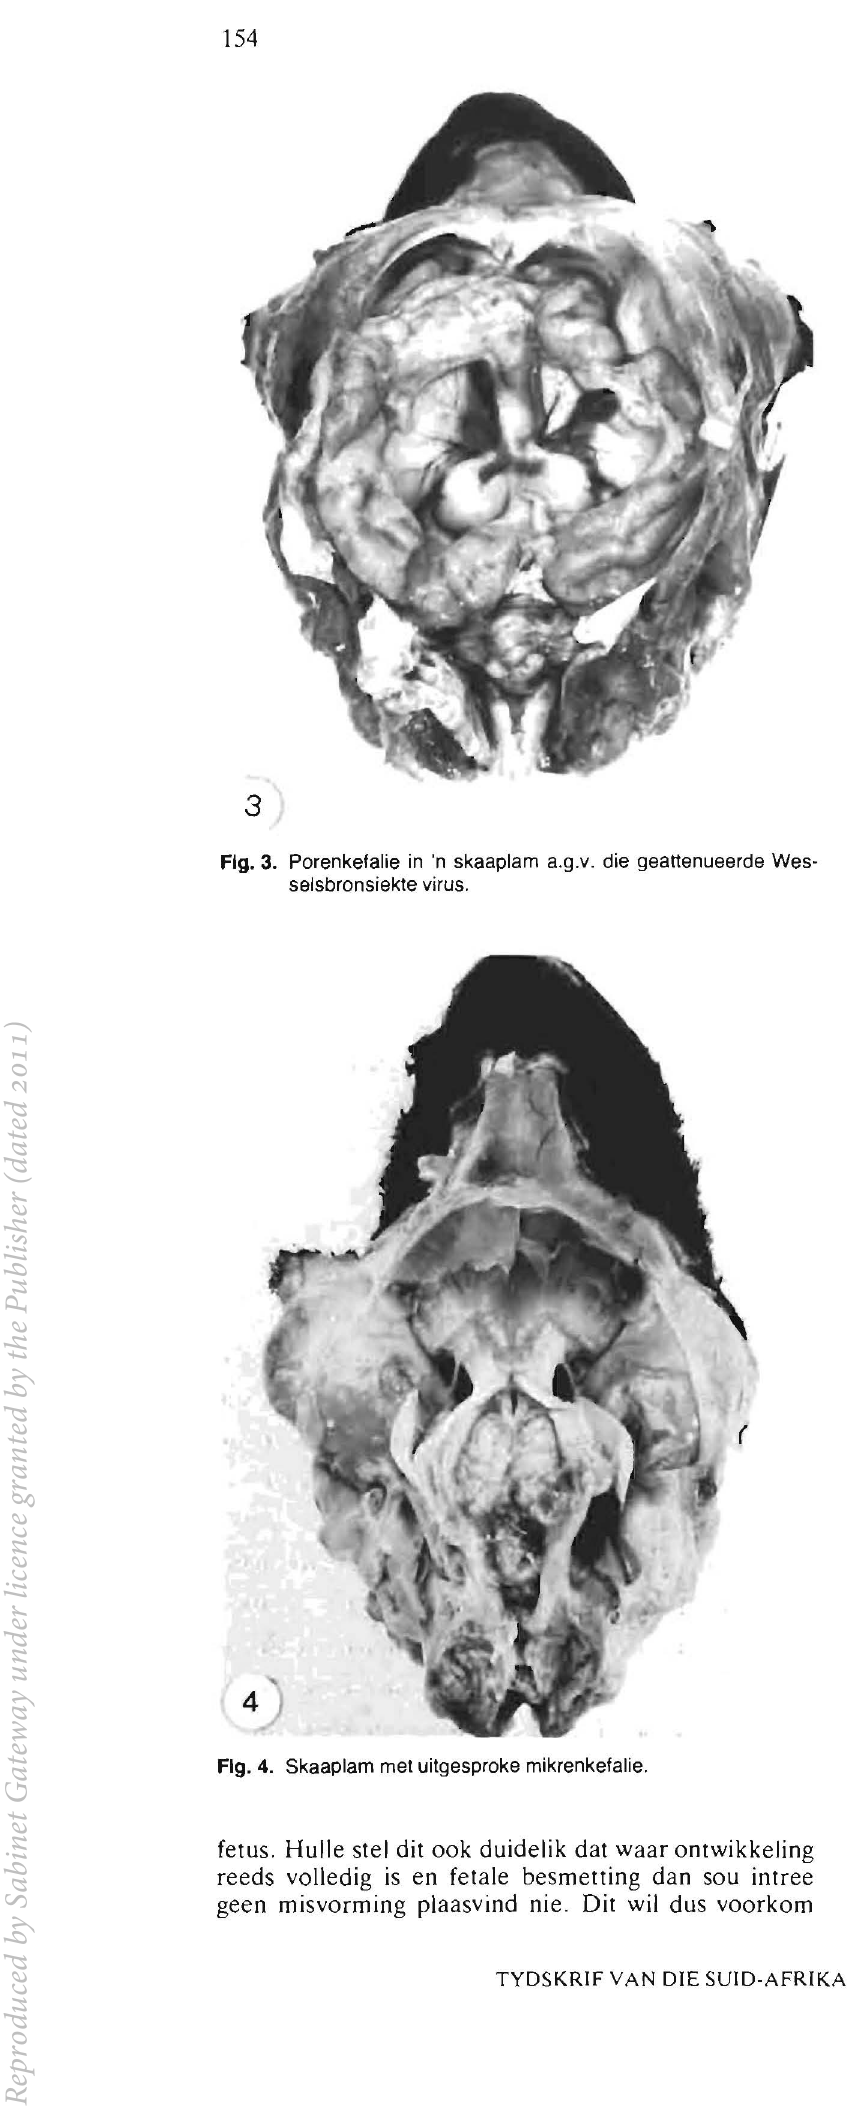
fetus. Hulle stel dit ook duidelik dat waar ontwikkeJing reeds volledig is en fetale besmetting dan sou intree geen misvorming plaasvind nie. Dit wil dus